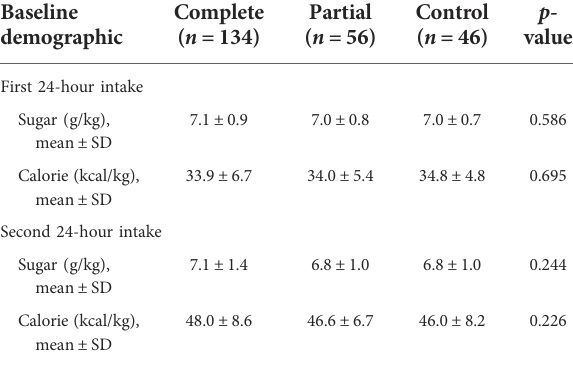
TABLE 2 Glucose and calorie intake of the study population within 48 h after